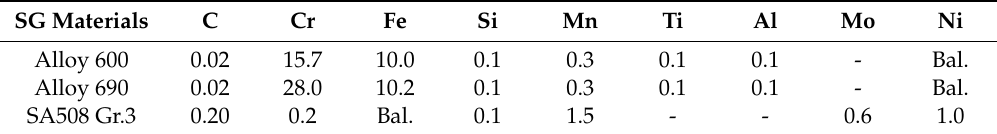
Table 1. Chemical composition of the SG materials of the PWR